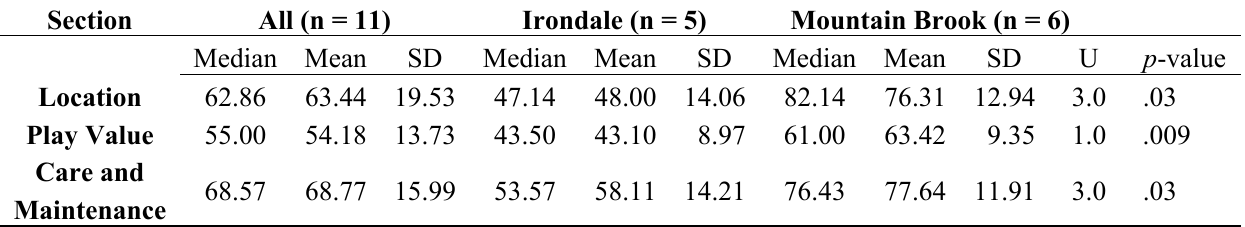
Table 3. Comparison of the summed scores in percentage of the three sections of the Playable Space Quality Assessment Tool on park quality of the two study cities.